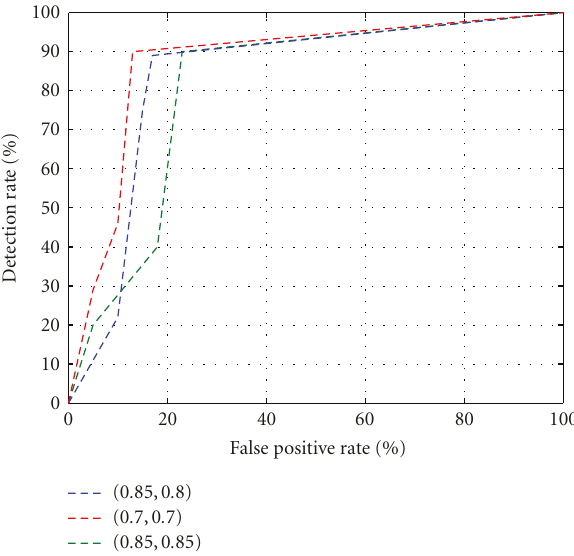
Figure 6: Performance of the geometric clustering algorithm according to ε 1 and ε 2